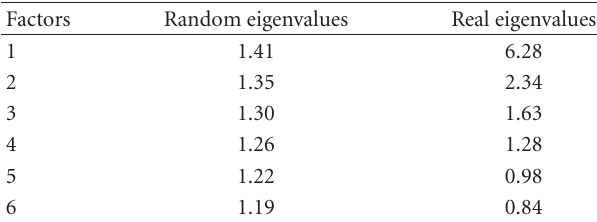
Table 2: The comparison of random eigenvalues (PA) and real eigenvalues for factor